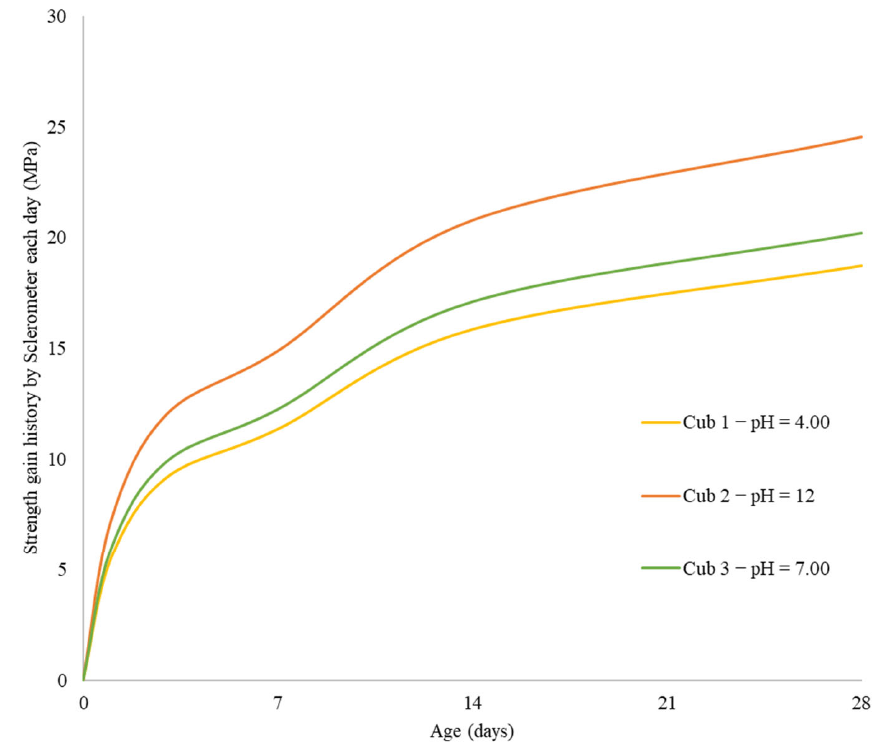
Figure 7. Strength gain data with time recorded by the sensor after every time interval of 0.5 h.